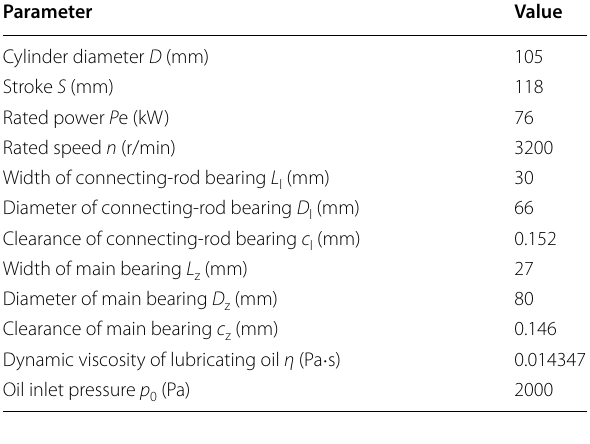
Table 1 Parameters of engine and